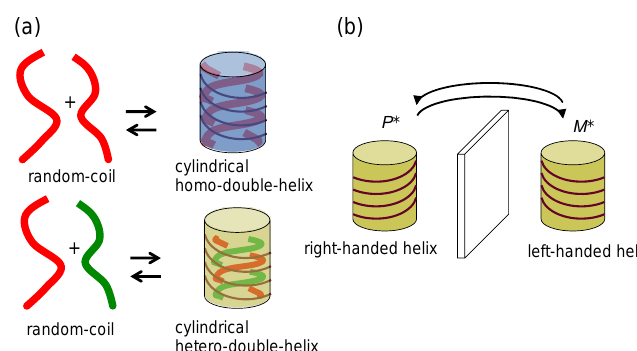
Figure 8. Interconversion between double-helix and random-coil ( a ) and interconversion between hetero-double-helix the enantiomeric three-dimensional structures ( b ).